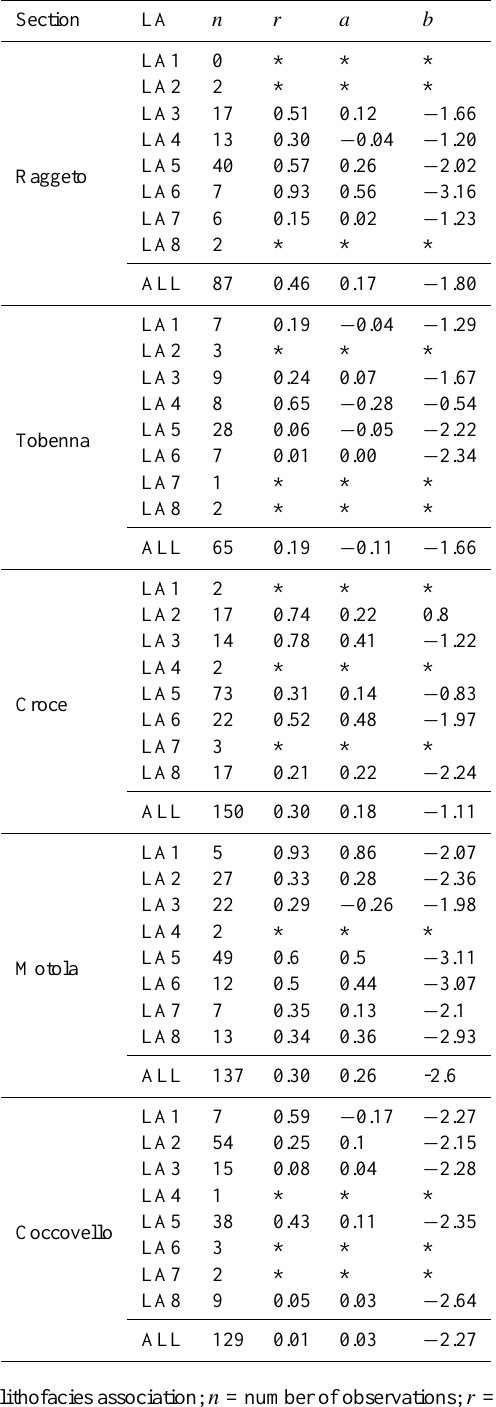
Table 3. Statistical results for C and O isotopes covariation in the studied